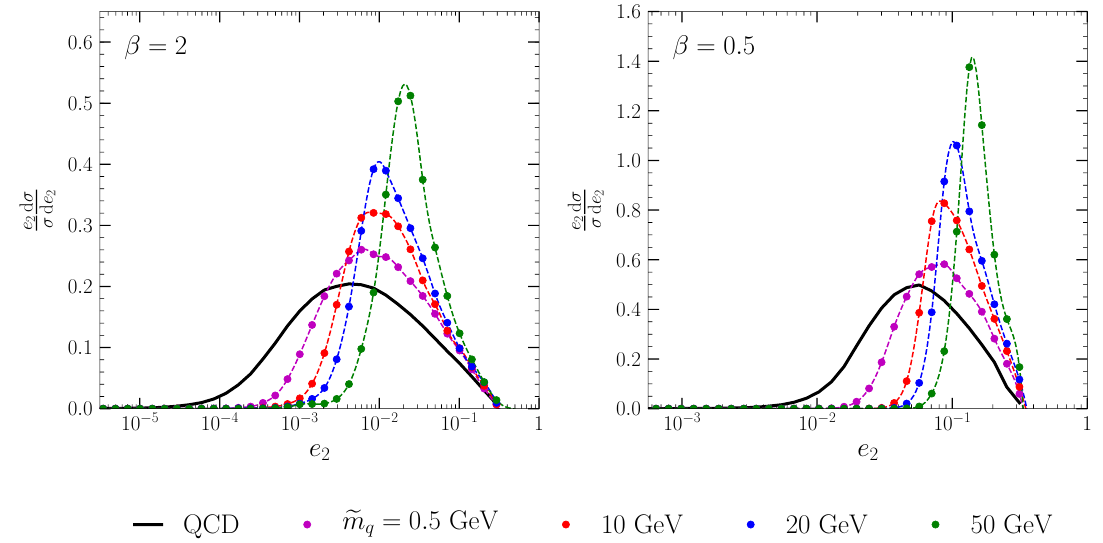
Figure 9 . The behavior of e 2 for the dark sector as the degenerate dark quark mass m q is varied, for e p T = 1 TeV jets. The value of m q is varied according to the legend, while all other values are given e in table 1. The associated dark hadron masses are 2 m q . Only a numerical study using Pythia e is presented. We provide a cubic fit to these distributions to guide the eye. Larger dark quark masses move the peak to higher values due to the resulting cutoff imposed on collinear divergences for emissions from massive quarks. We show the results for two choices of the angular dependence: (cid:12) = 2 [left] and (cid:12) = 0 : 5